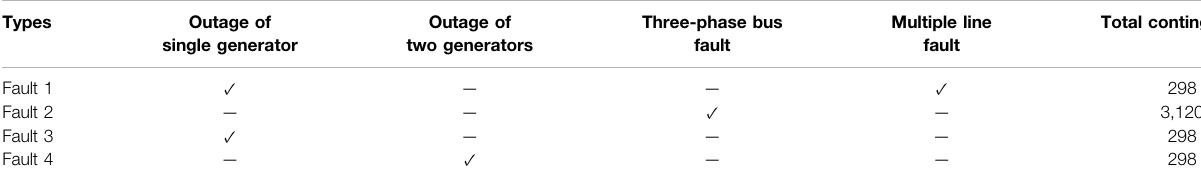
Table 1 . Fault 1 is the single generator and multiple line fault. In this scenario, each generator and consequently two transmission lines were tripped in the system. A total of 298 contingencies were simulated for Fault 1. For Fault 2, a three-phase fault at a bus during dynamic simulations was applied to the Polish system with 3,120 contingencies. Different generators were set to be tripped during dynamic simulation for the system, as Faults 3 and 4, with 298 contingencies for each fault type. In Fault 3, each generator was put out-of-service and Fault 4 has the two neighboring generators out-of-service.